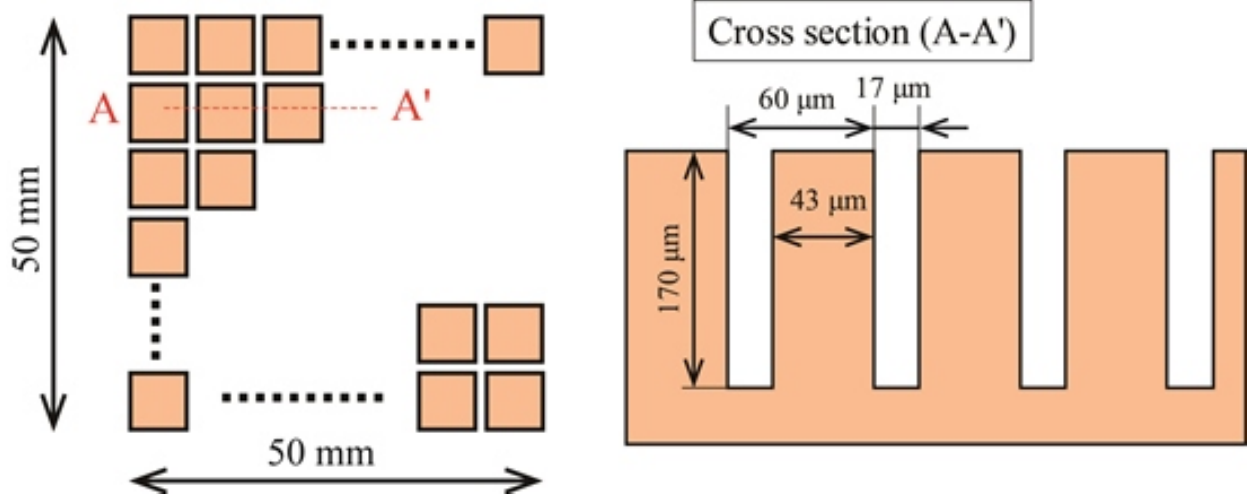
Figure 1. Design of sample having high-aspect-ratio pillar